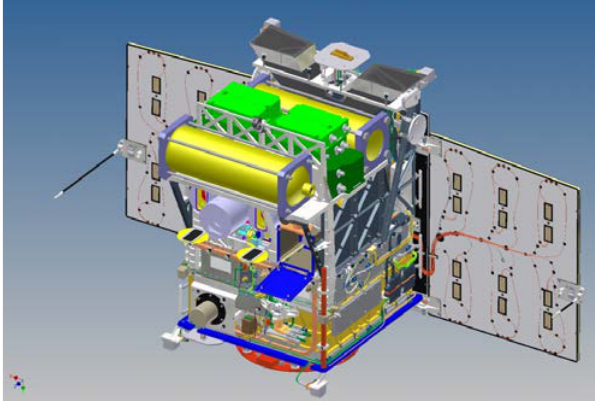
Figure 2 BIROS Satellite with the Payload Segment